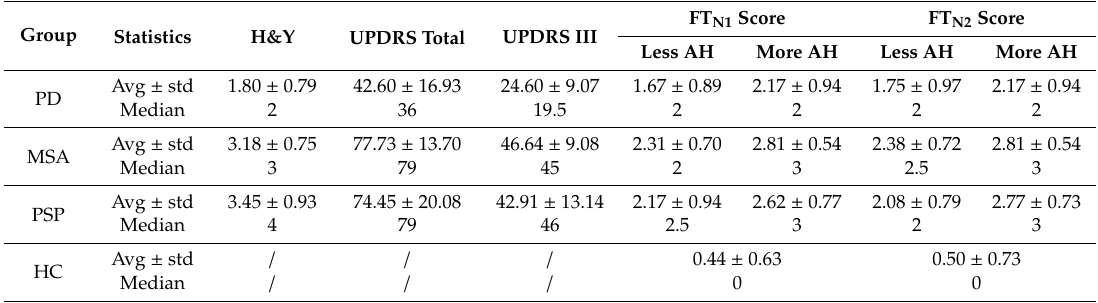
Table 1. Descriptive statistics of the subjects’